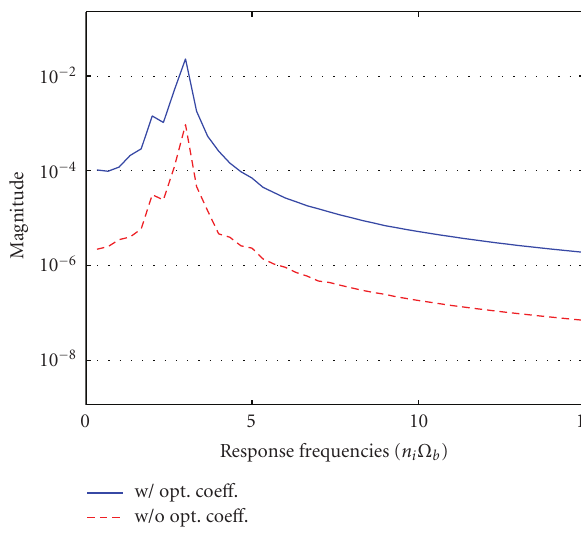
Figure 13: Vert. response mag. profiles at Ω b = 2 . 2, bearing 2.